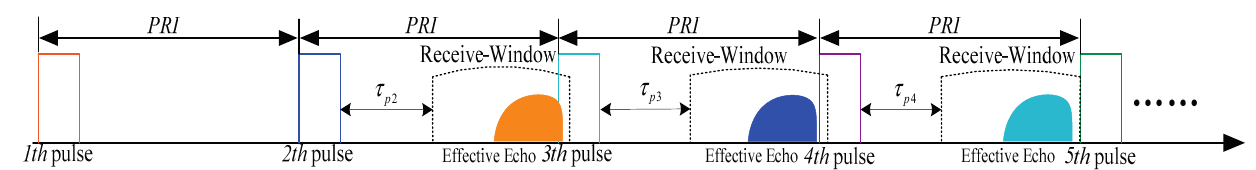
Figure 3. An example when the sliding receive-window method is not